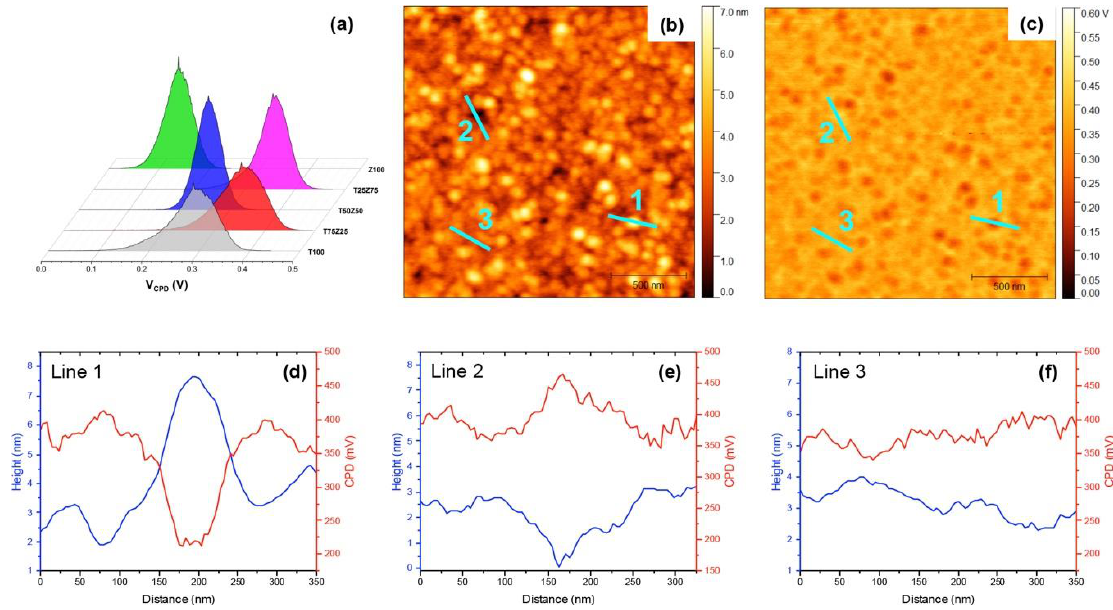
Figure 4. ( a ) Surface potential V CPD histograms of TiO x :Zn 1−x Cd x S nanocomposite films, ( b ) topography and ( c ) its corresponding surface potential image, ( d – f ) Profiles extracted from topography and surface potential at three different locations of T25:Z75 film.